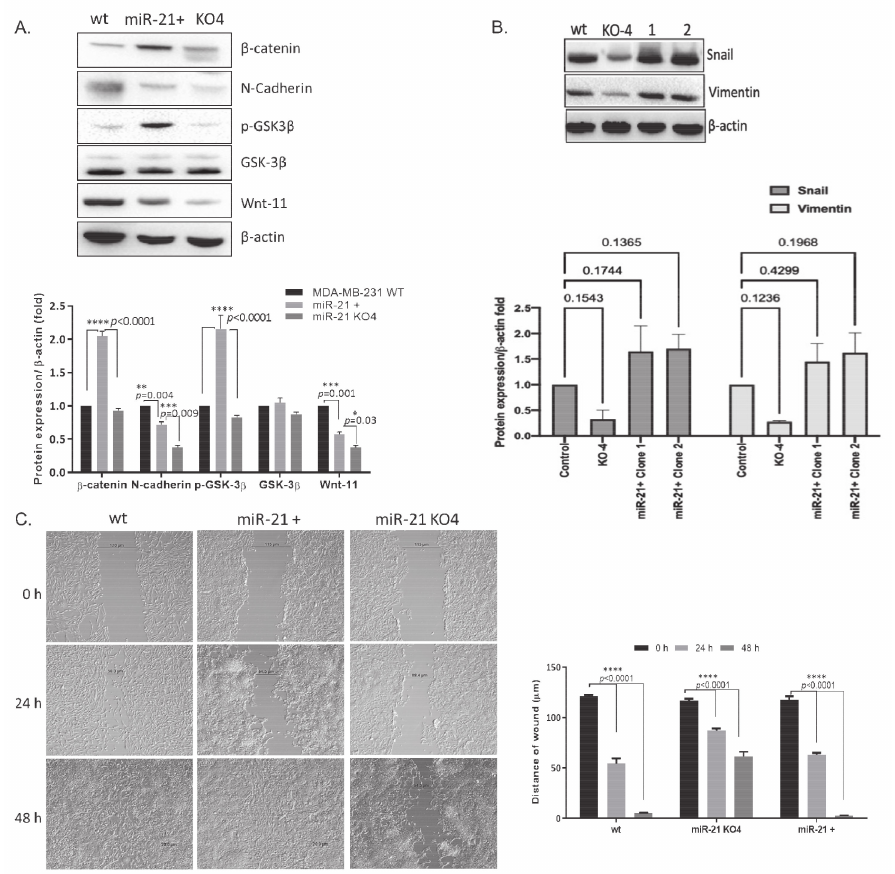
Figure 7. miR-21 increased the motility of miR-21 KO cells through modulating the Wnt-11, β -catenin, and GSK3 β axis to promote mesenchymal markers. ( A ) The total protein was isolated from MDA-MB-231 wt, KO4, and miR-21 retransfected KO4 cells (miR-21+). The expression levels of N-cadherin, vimentin, β -catenin, p-GSK-3 β , and Wnt-11 were examined by Western blot analysis. β -actin was used as a loading control. Relative band intensities were calculated by normalizing the values against β -actin. Each data point represents average ± SD. * p < 0.05, ** p < 0.01, *** p < 0.001, **** p < 0.0001. ( n = 3) ( B ). The total protein was isolated from MDA-MB-231 wt, KO4, and miR-21 retransfected KO4 cells (miR-21+). The protein expression levels of Snail and Vimentin were examined by Western blot analysis. β -actin was used as a loading control. Relative band intensities were calculated by normalizing the values against β -actin. Each data point represents average ± SD. **** p < 0.0001. ( n = 3) ( C ). Wound healing assay was performed to compare the motility of KO4 cells with miR-21+ cells. Images were obtained by using light microscopy with 10 × magnification. The scale bar is 100 µ m. The average distance of wound area was shown following measurement of at least 5 different areas for 0, 24, and 48 h incubation time. Each data point represents average ± SD of three separate